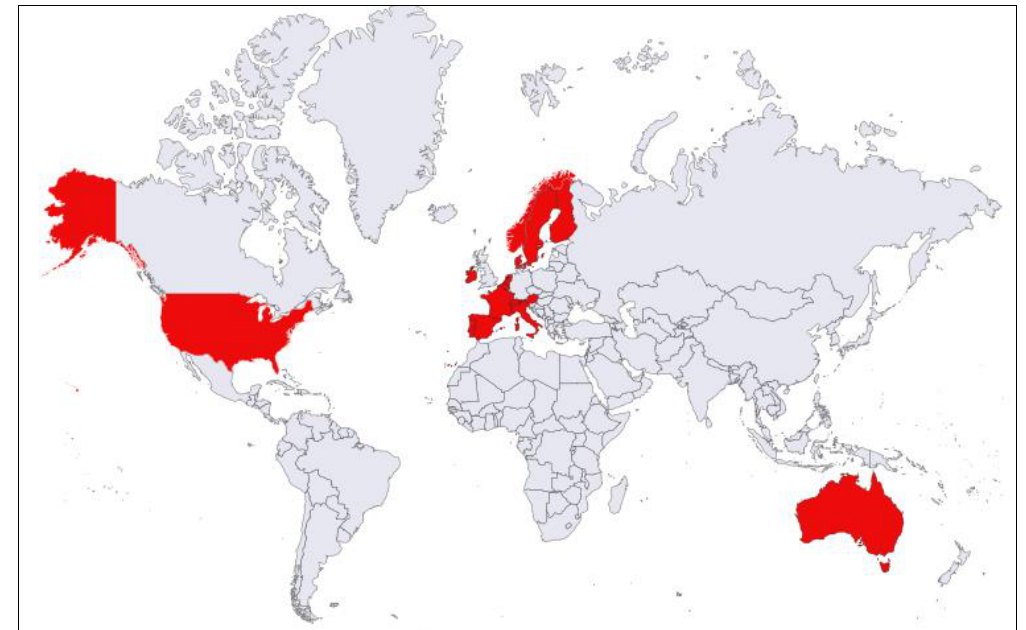
Figure 1. Fifteen selected developed countries